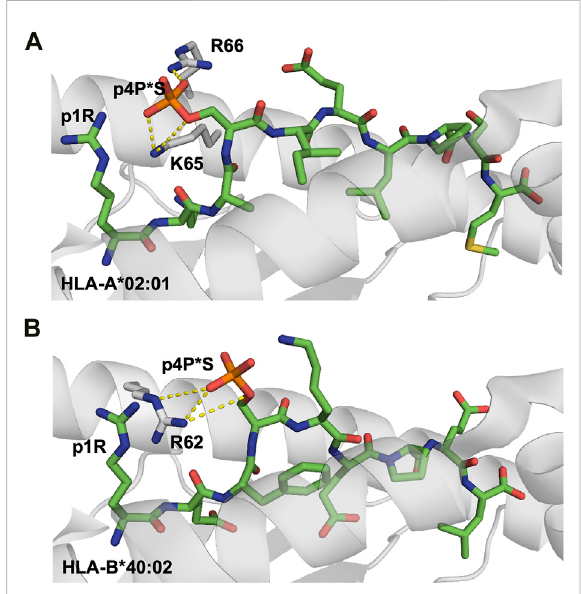
FIGURE 3 Phosphorylation of MHC-I peptide residues may act as additionalexternalanchorpositions,increasingsigni fi cantlypMHC stability (A) .Phosphorylationofthesolvent-exposedserineresidue at p4 in the HLA-A0201-restricted decameric Lymphocyte speci fi c protein 1-derived peptide (3BH8. pdb) (Mohammed et al., 2008) results in the formation of strong electrostatic interactions between the negatively charged phosphoserine moiety and the surrounding MHC-I residues R66 and K65. Additional interactions are also formed between the phosphorylated moiety and the side chain of peptide residue p1R. Interactions between the phosphate moiety and the basic HLA residues are displayed with yellow dashed lines (B) . Similarly, besides forming a hot spot for TCRs, the phosphorylation of the exposed residue in a nonameric peptide derivedfromtheinnercentromereproteinboundtoHLA-B*40:02 (2IEH.pdb) (Alpízar et al., 2017) increases signi fi cantly the overall stability of the modi fi ed pMHC complexes through the formation of electrostatic interactions with surrounding MHC heavy chain and peptide